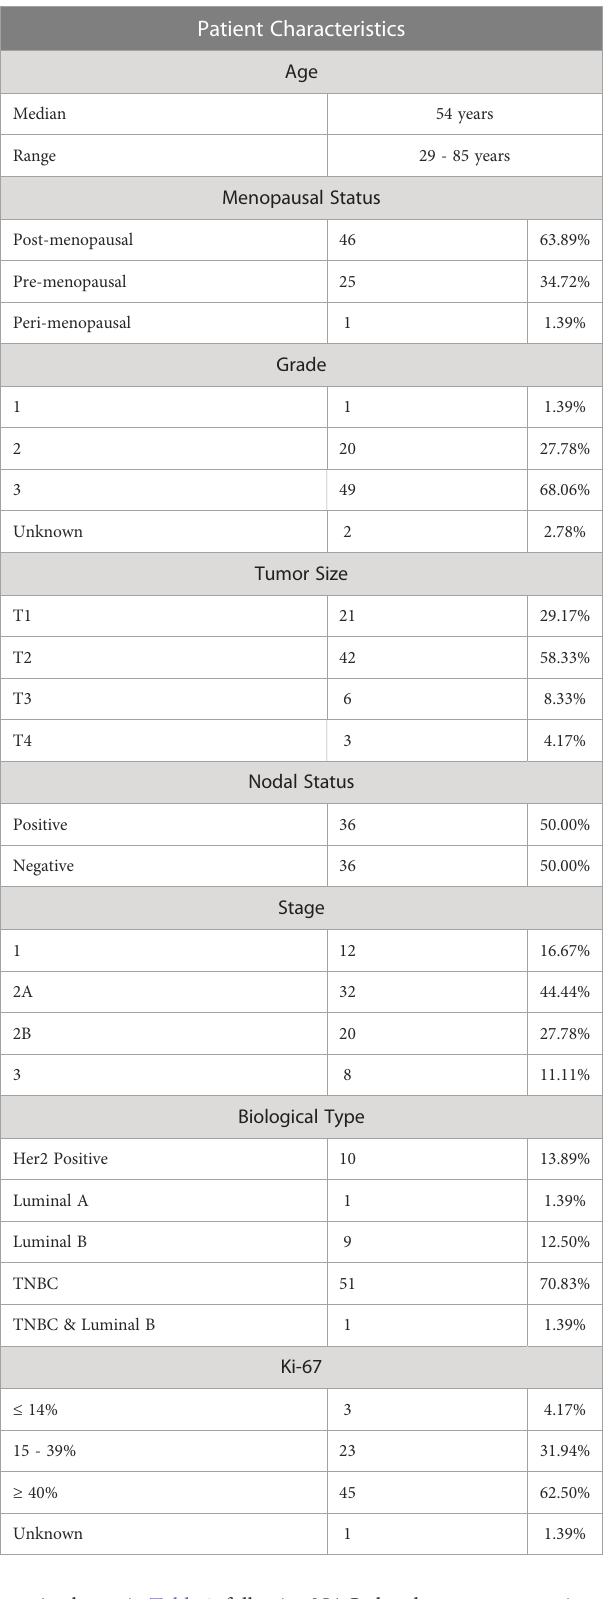
TABLE 1 Demographic and clinical data of the cohort of newly diagnosed early breast cancer patients. Patient